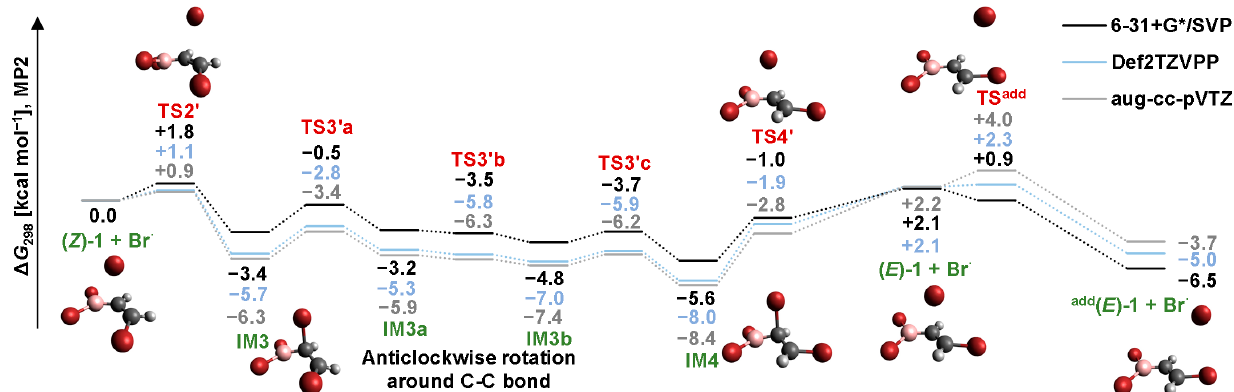
clockwise rotation around the C–C bond. For a key to atom color scheme, cf. caption of Figure 1.